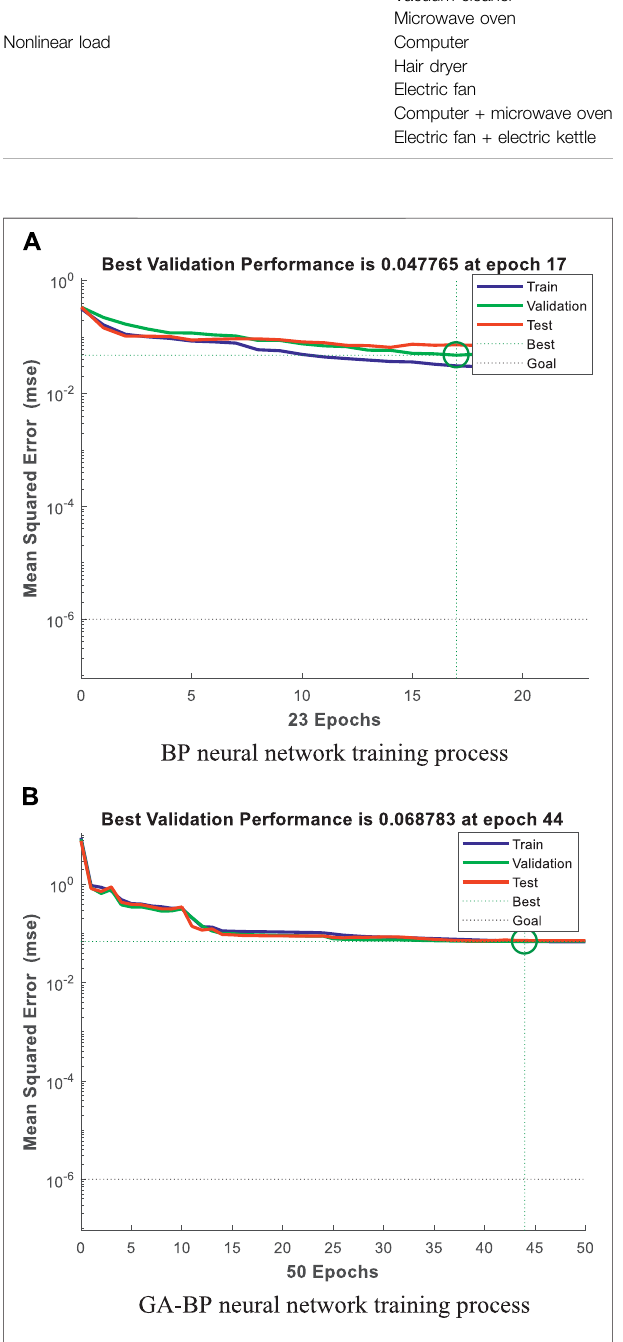
FIGURE 15 | Two kinds of the network training process. (A) BP neural network training process. (B) GA-BP neural network training process.